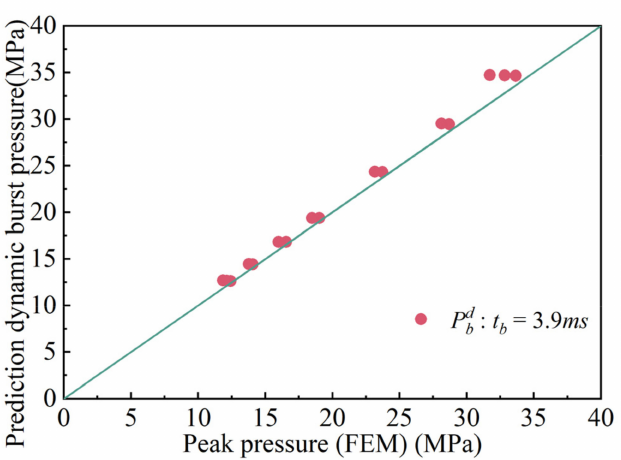
Figure 7. Comparison results with pulse duration t d = 3.9ms.